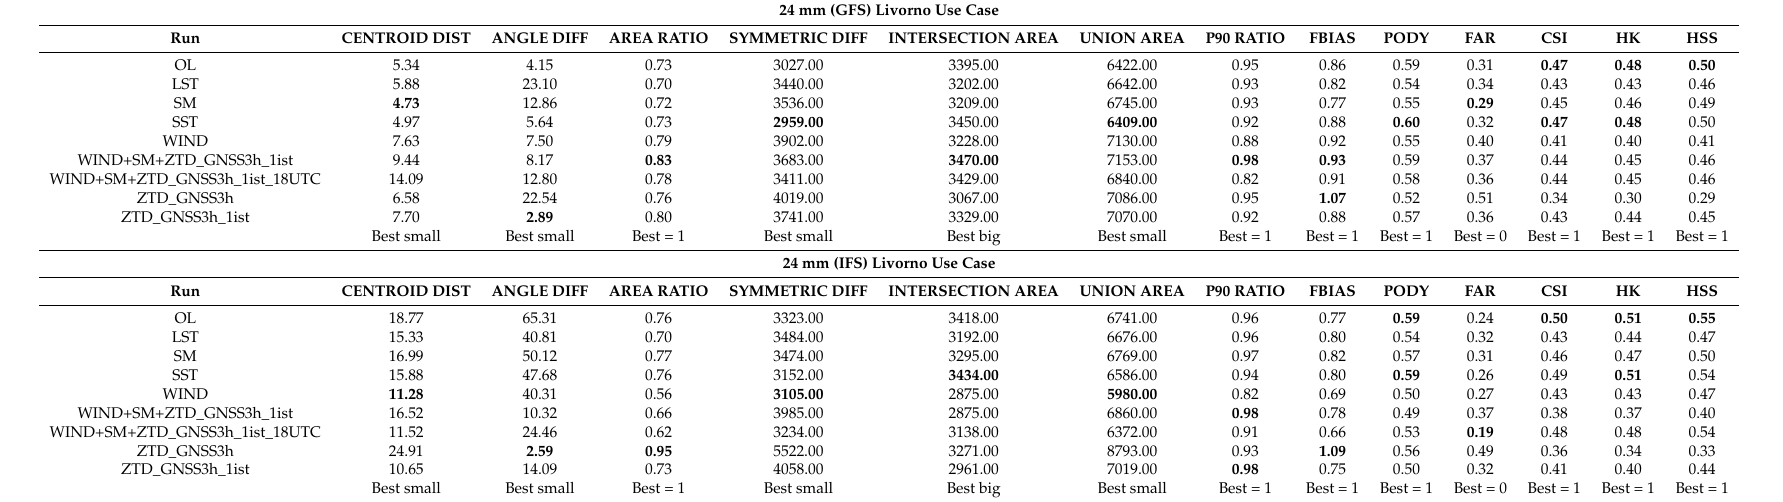
Table A2. Spatial and statistical indices calculated through MODE (24 mm rainfall depth threshold) to evaluate the sensitivity forecasts (driven by GFS and IFS respectively) with respect to the Open Loop run for the time interval 18UTC 09/09/2017–06UTC 10/09/2017. The best performance for each score is highlighted in